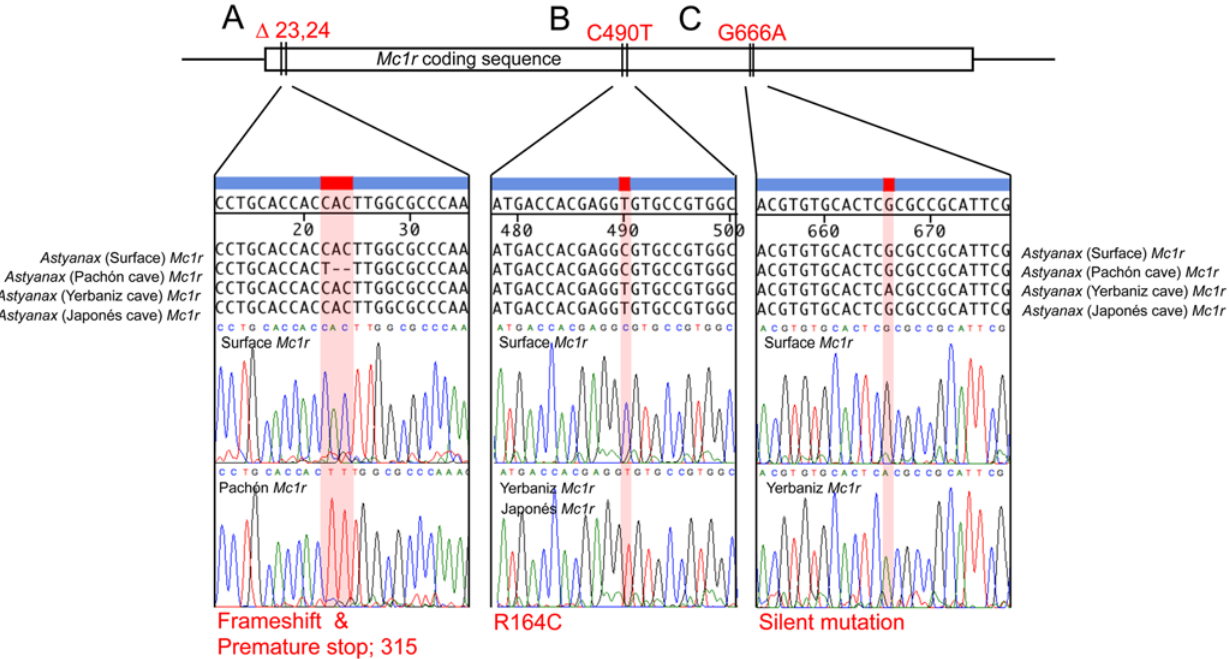
Figure 3. Sequence analyses of Mc1r open reading frame in Surface, Pacho´n, Yerbaniz and Japone´s cavefish of Astyanaxmexicanus reveal three coding mutations. A schematic representation of the Mc1r coding sequence is shown with each of three mutations identified in our sequence analyses. (A–C) Each of the three mutations is magnified to show nucleotide alignments for the Surface, Pacho´n, Yerbaniz and Japone´s alleles of Mc1r . Below each alignment is the representative chromatogram sequence data for the Surface (wild type) compared with variant sequences. Three coding alterations were observed in three of a total nine caves completely sequenced for Mc1r in this study. (A) A 2-bp deletion at positions 23,24 was discovered in members of the Pacho´n cave population of Astyanax . This 2-bp deletion (red) causes a frame-shift and the introduction of a premature stop codon at nucleotide position 315. (B) We discovered an additional mutation at position 490 that causes an arginine to cysteine modification at amino acid position 164 (red). The identical mutation was discovered through analyses of both the Yerbaniz and Japone´s populations, however these caves are likely members of the same cave population, possibly joined via a subterranean interconnection. (C) An additional silent mutation (G666A; red) was observed only in Yerbaniz